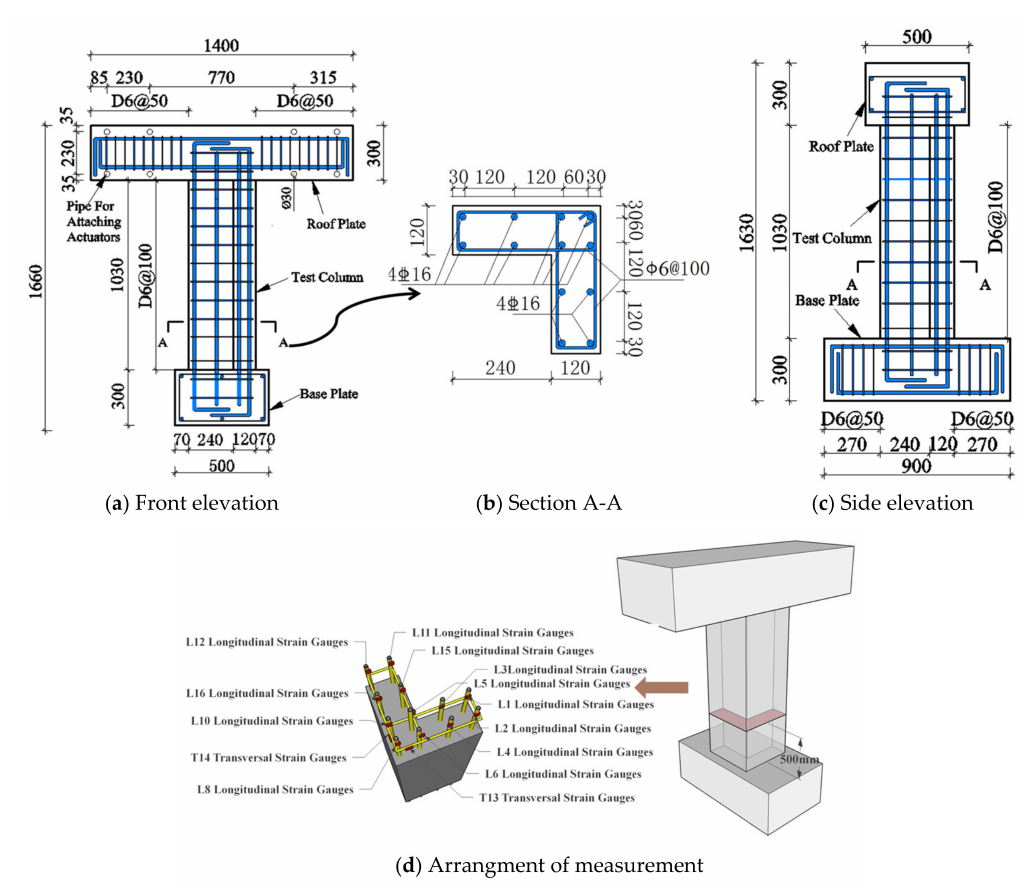
Figure 2. Detailed design of specimens (unit: mm).